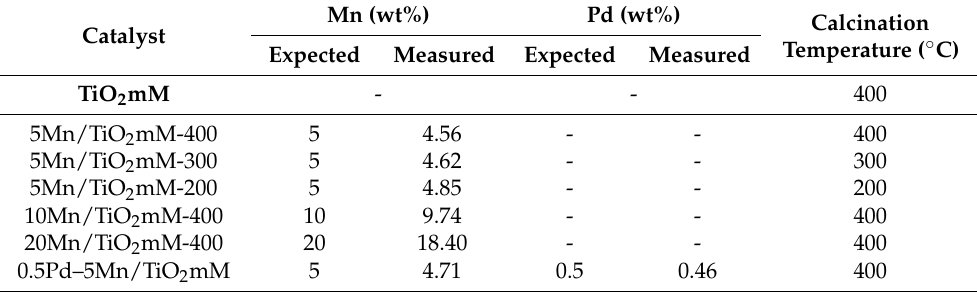
Table 1. Labels and expected and measured (ICP) chemical composition of the catalysts in powdered